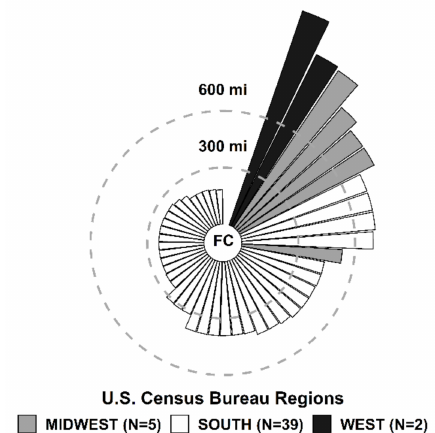
Figure 1. (Miles) from the fetal center (FC) to delivery hospital associated with referring physician in 46 patients who were discharged home 2 weeks after prenatal myelomeningocele (MMC)